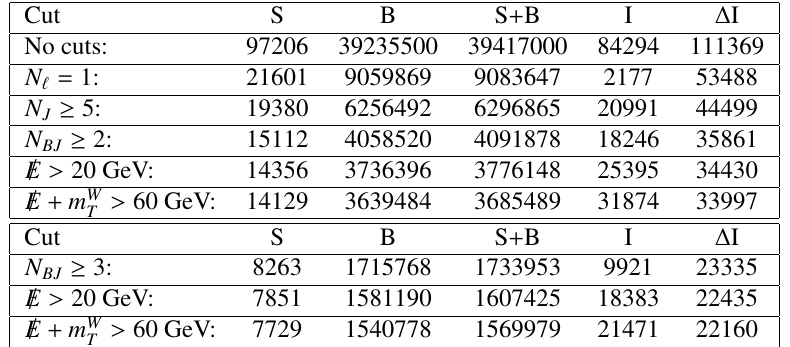
Table 2. Cut flow results presented in expected event yield with 3000 fb − 1 of luminosity for the h MSSM